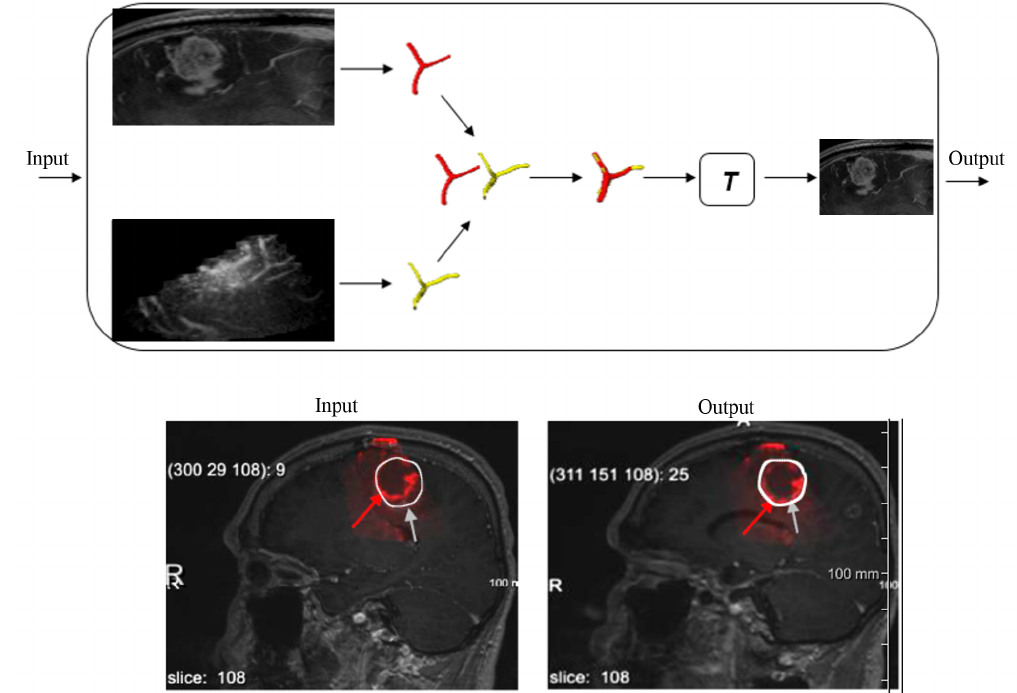
Figure 6. Application of vascular structure identification in brain shift correction between cT1MR and 3D-iCEUS start